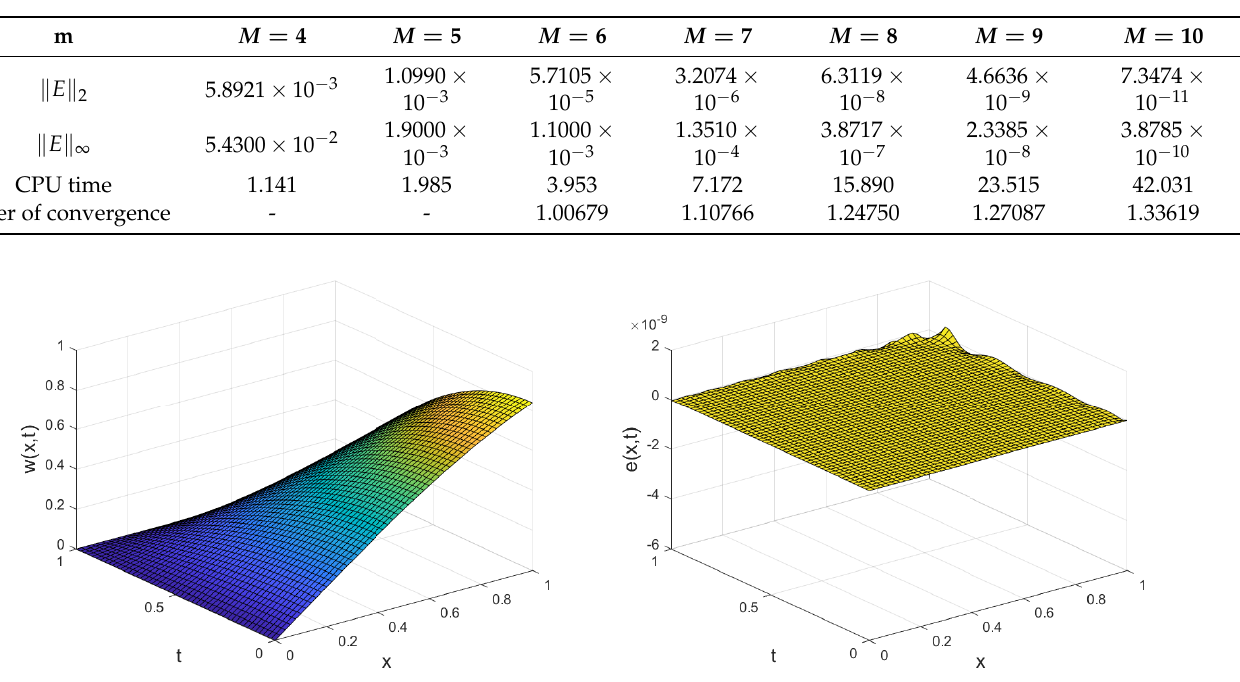
Table 2. The L ∞ , L 2 errors and CPU time for Example 1.